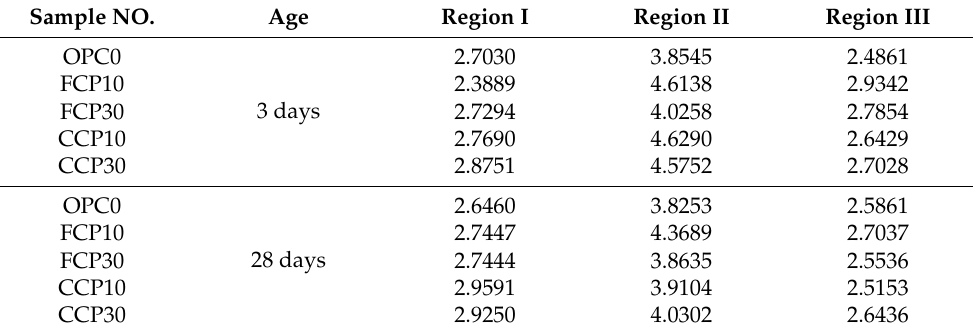
Table 5. Multifractal analysis of coral powder–cement slurry by Pfeifer and Avnir’s model. Sample